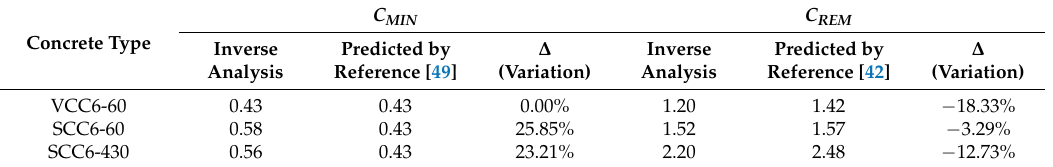
Table 5. Comparison of the predicted values in References [11,42] to those obtained in this study by inverse